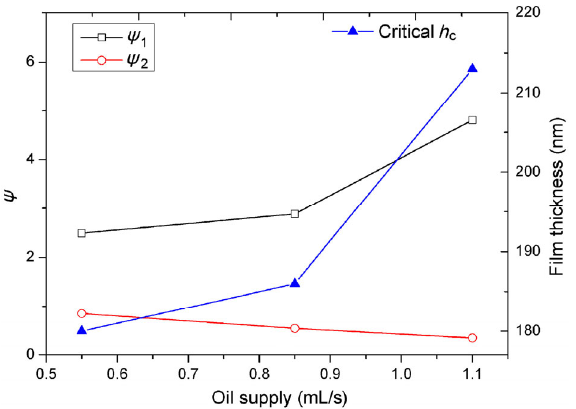
Fig. 5 Changes of the paramter ψ in stage I ( ψ 1 ) and stage II ( ψ 2 ) against oil supply rate, pure rolling, p H = 431 MPa, t 0 = 25 ° C, PAO8.